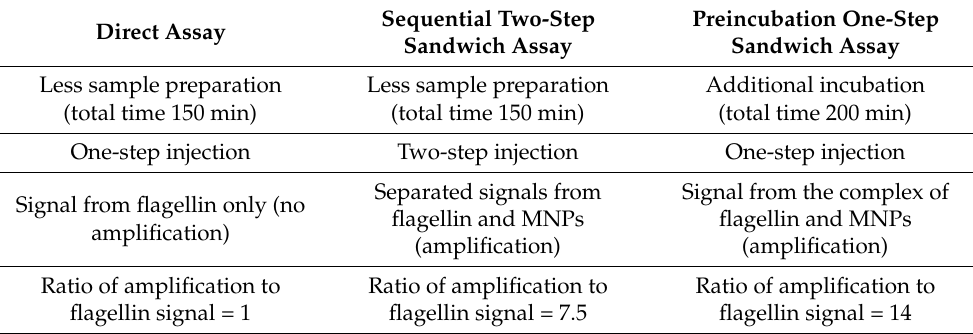
Table 2. Comparisons of performance of the three SPR